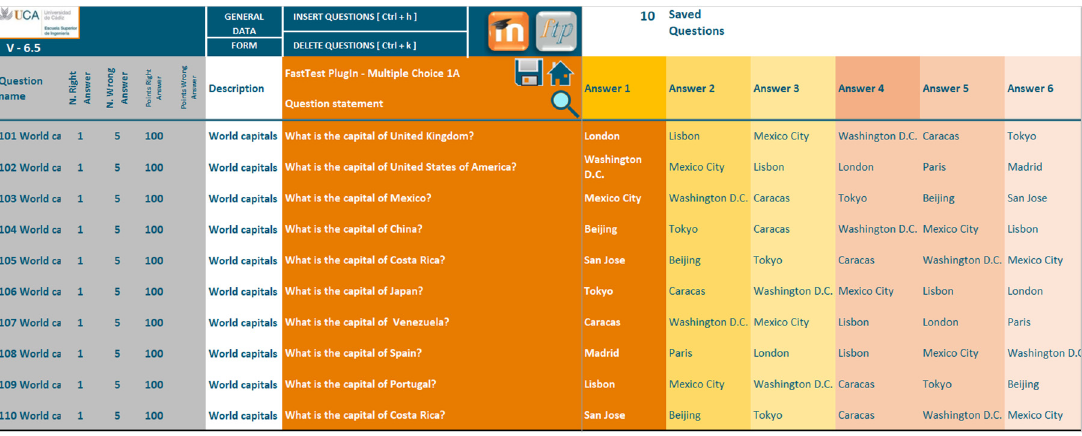
Figure 5. Example of a parameterised question with text values.